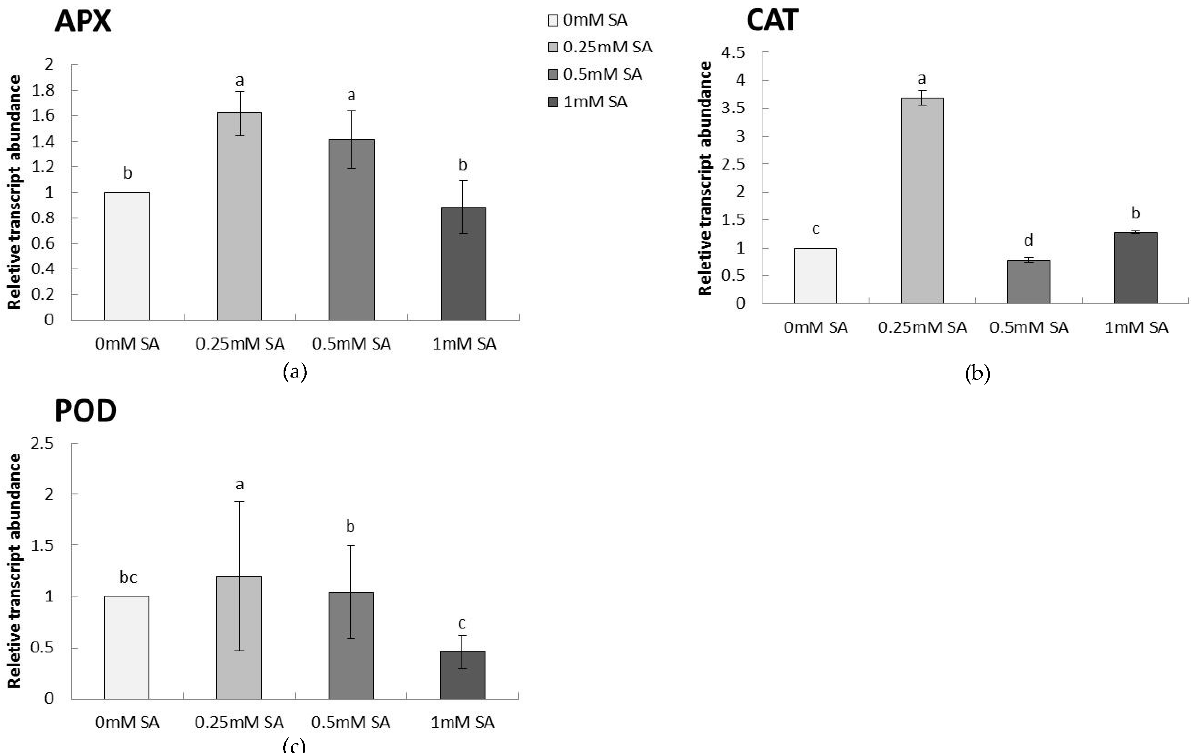
Figure 4. Effect of SA treatment on the relative abundance of APX ( a ), CAT ( b ) and POD ( c ) transcripts determined through RT-qPCR in perennial ryegrass under 250 mM NaCl stress. The values are the means ± SD ( n = 4). The different letters indicate significant differences between various SA treatments ( p ≤ 0.05).